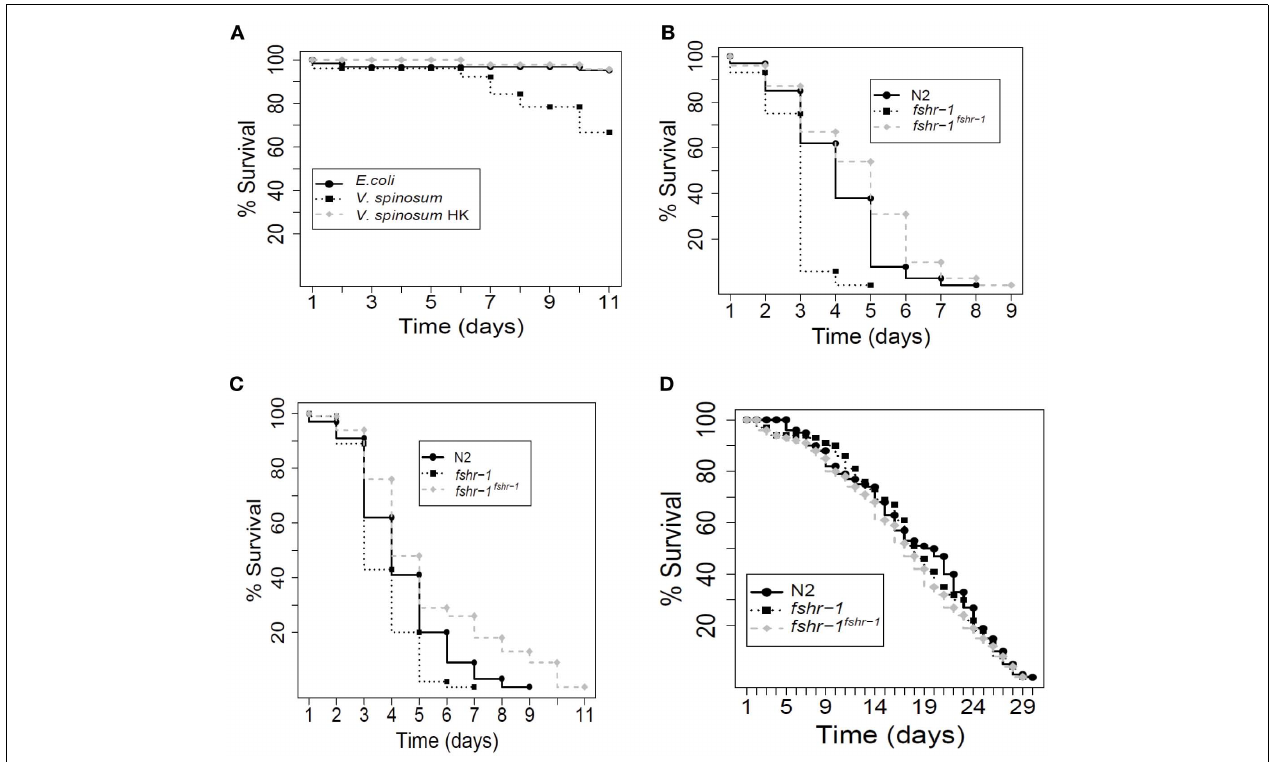
FIGUREA1 | Caenorhabditis elegans survival assays. Each experiment comprised approximately 100 worms. (A) Wild-type worms (N2) exposed to live V. spinosum died faster than worms exposed to E. coli , according to log-rank analysis ( p = 3.71 e − 7 ), whereas worms exposed to heat-killed V. spinosum died no faster than worms exposed to E. coli ( p = 0.319). (B) When exposed to S. aureus , worm mutants hypersensitive to pathogens ( fshr-1 ) died faster than N2 wild-type worms ( p = 9.66 e − 15 ). fshr-1(ok778) worms over-expressing wild-type fshr-1 from a multi-copy transgenic array died more slowly than N2 wild-type